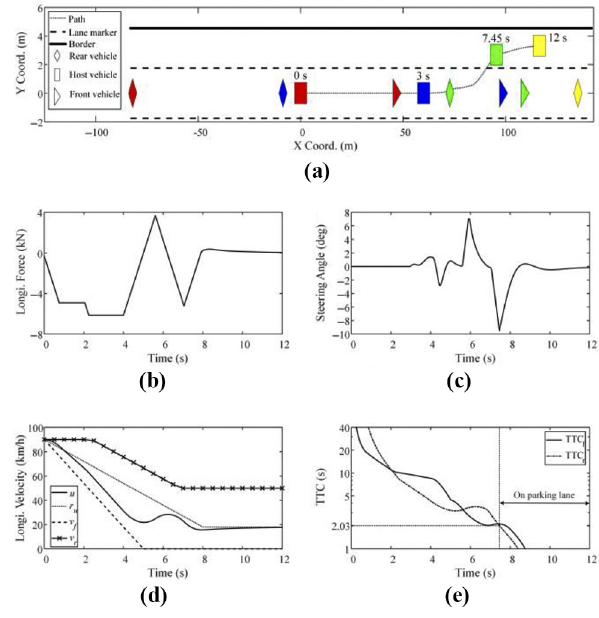
Figure 8 Numerical analysis results of scenario 2 Figure 7 Numerical analysis results of scenario